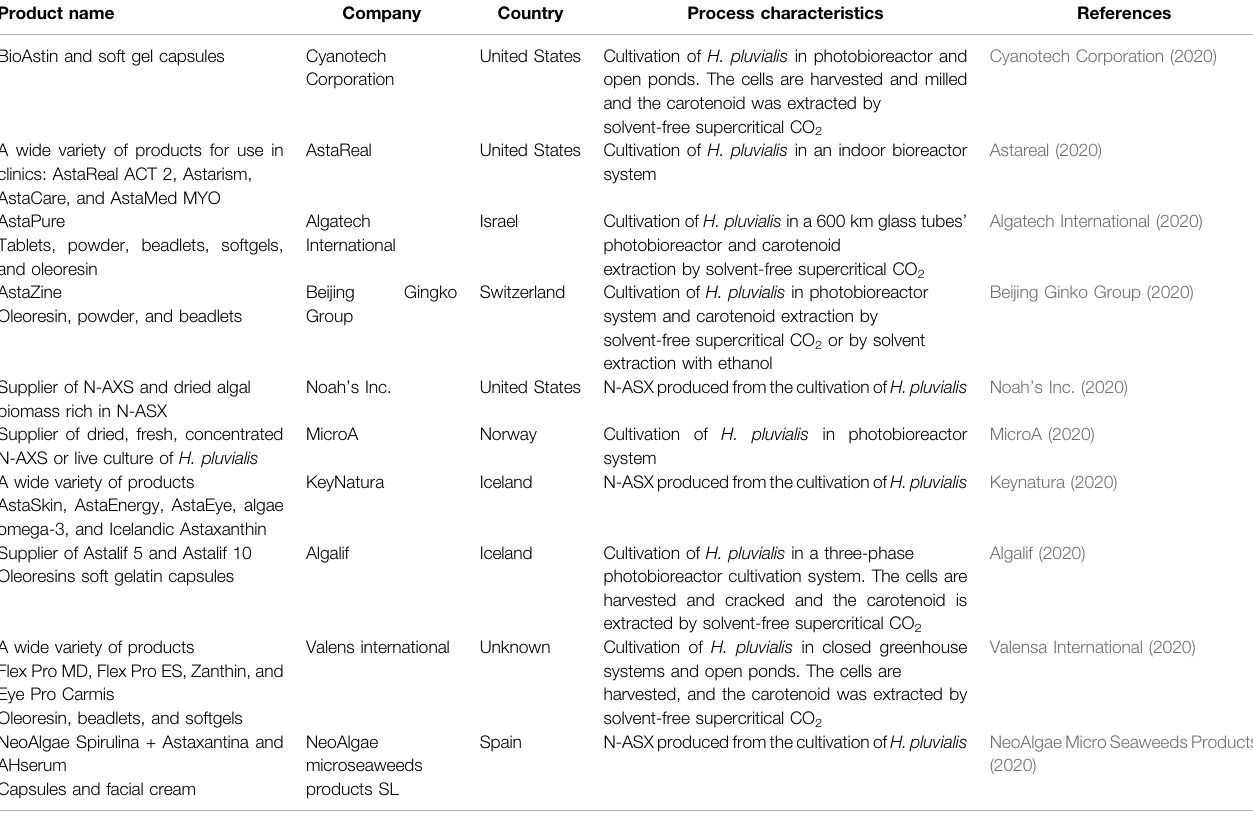
TABLE 2 | Top ten ranked N-ASX-producing companies over the world according to Venture radar (2020).